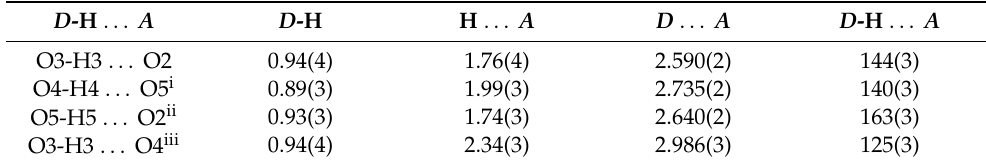
Figure 2. Hydrogen bonding network of alternariol—Form II. The middle molecule is surrounded by six other molecules and has classical H-bonding interactions with four of them. Table 2. Hydrogen-bond geometry (Å, °) of alternariol—Form II.